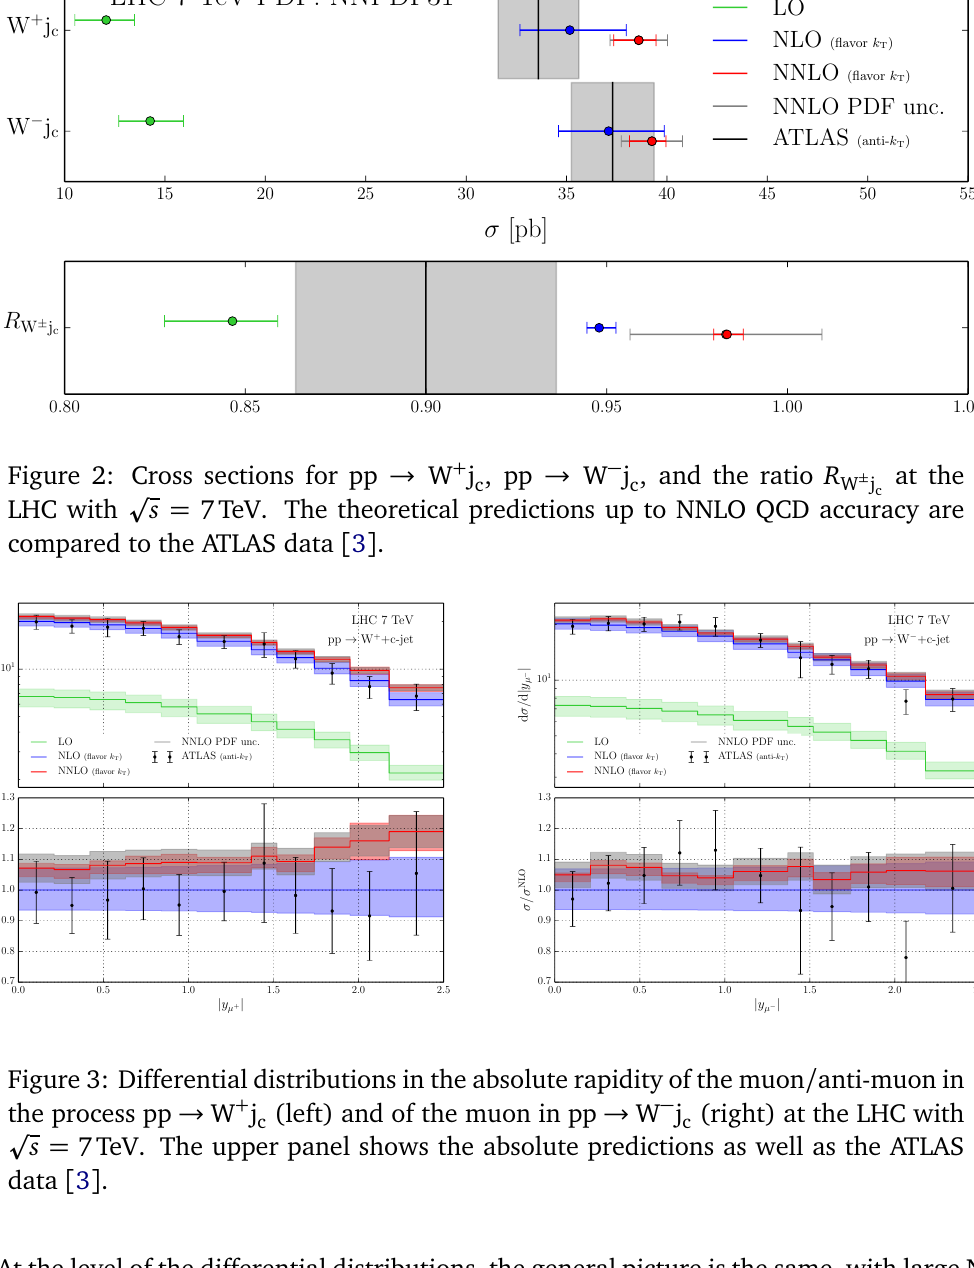
(right) at the LHC with (cid:112) c